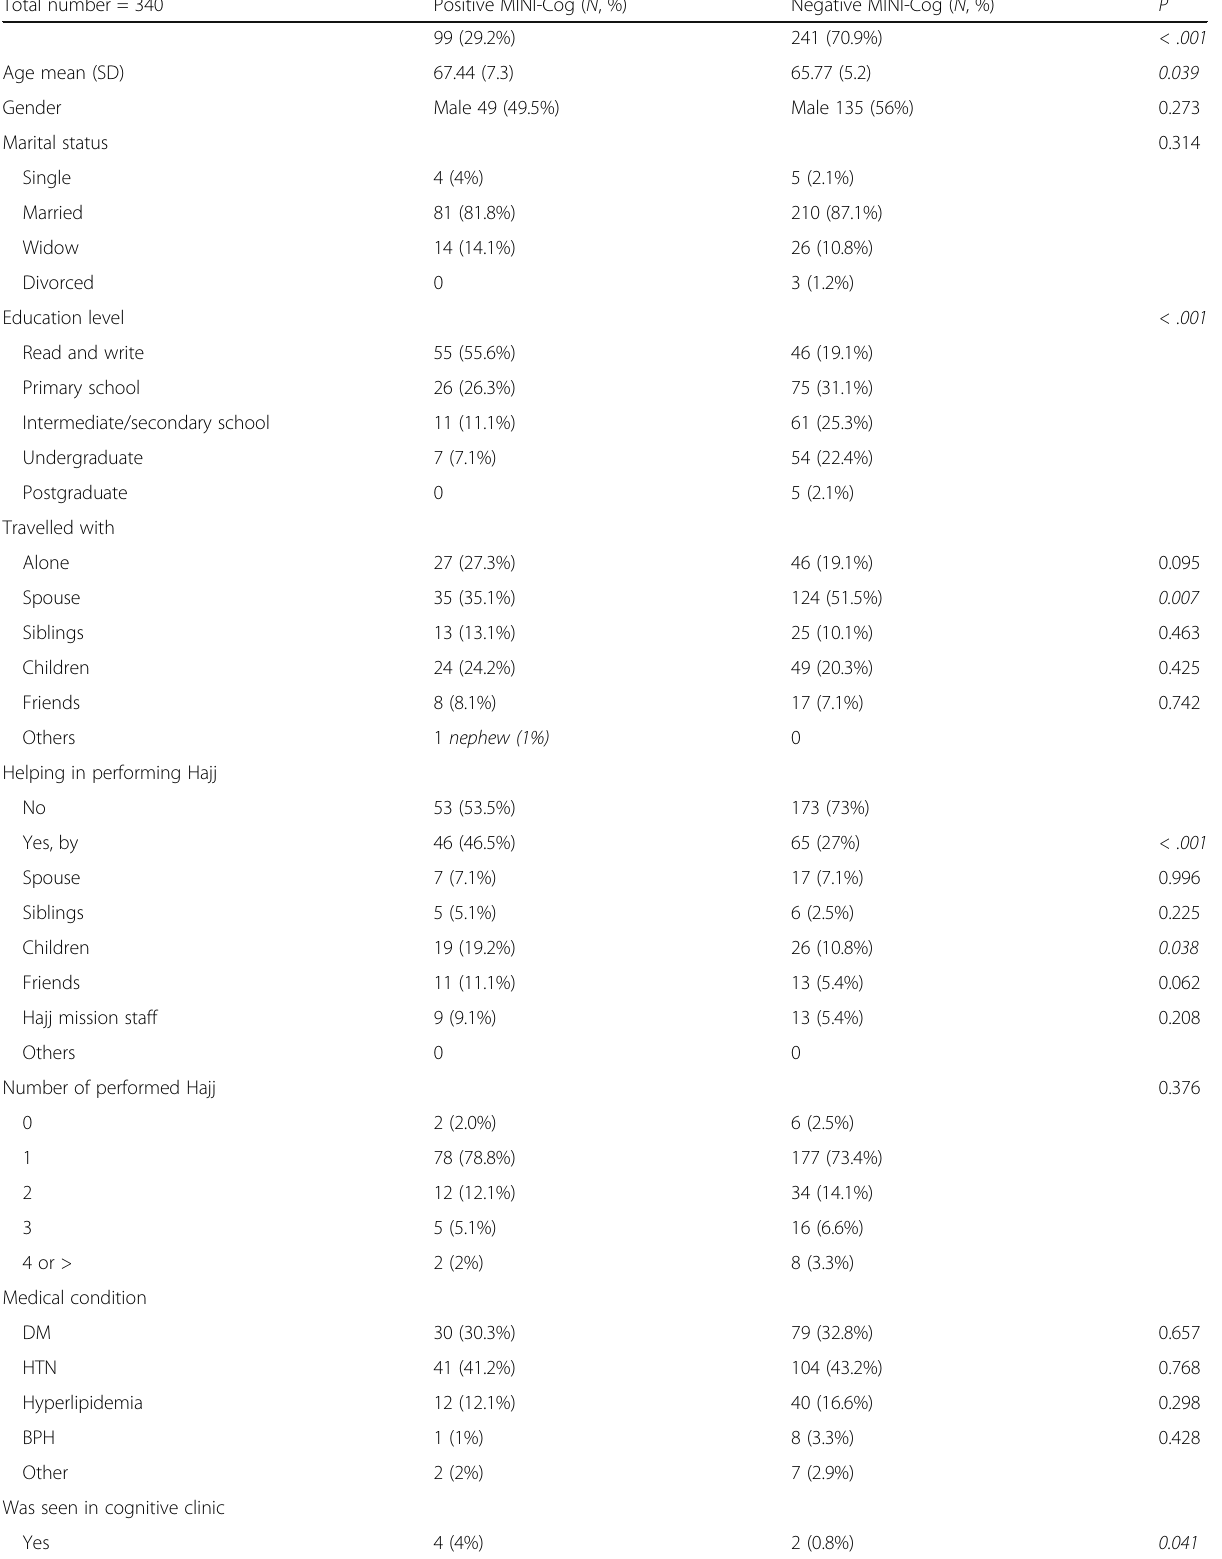
Table 1 Demographic and clinical characteristics of Hajj pilgrims with and without positive MINI-Cog